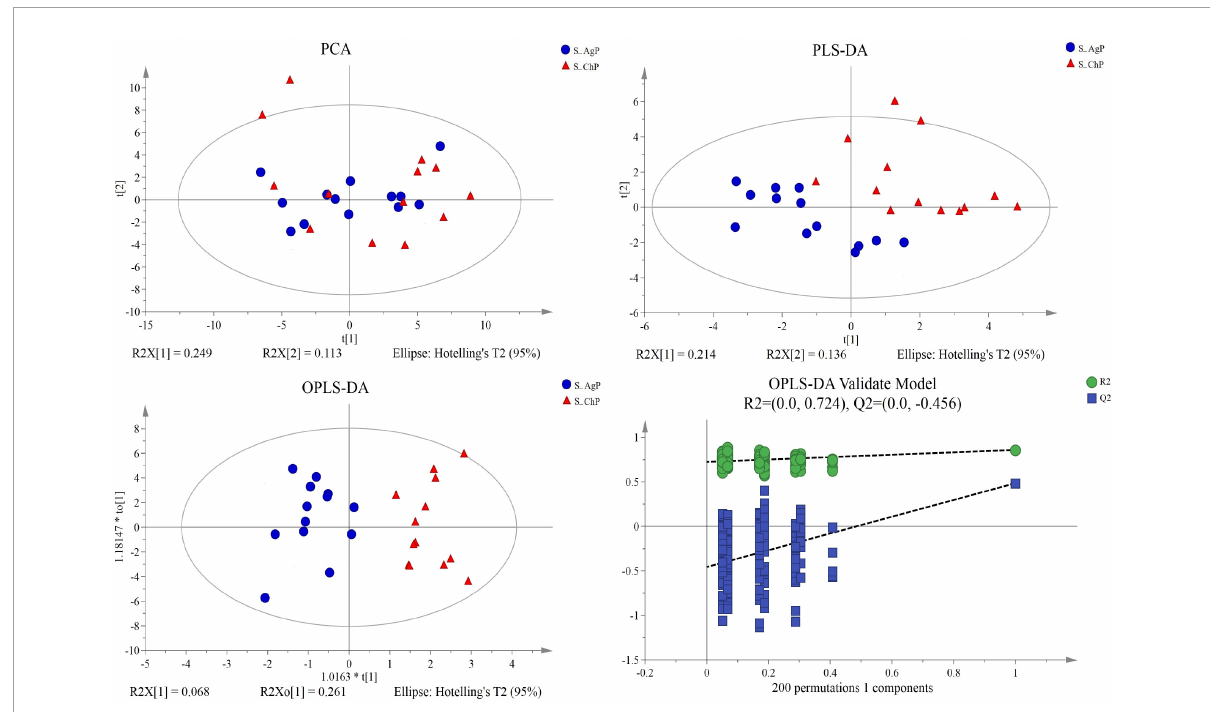
FIGURE6 Dissimilarity in salivary metabolic signatures between AgP and ChP. PCA analysis (A) , PLS-DA analysis (B) , OPLS-DA analysis (C) , and response permutation testing of OPLS-DA (D)